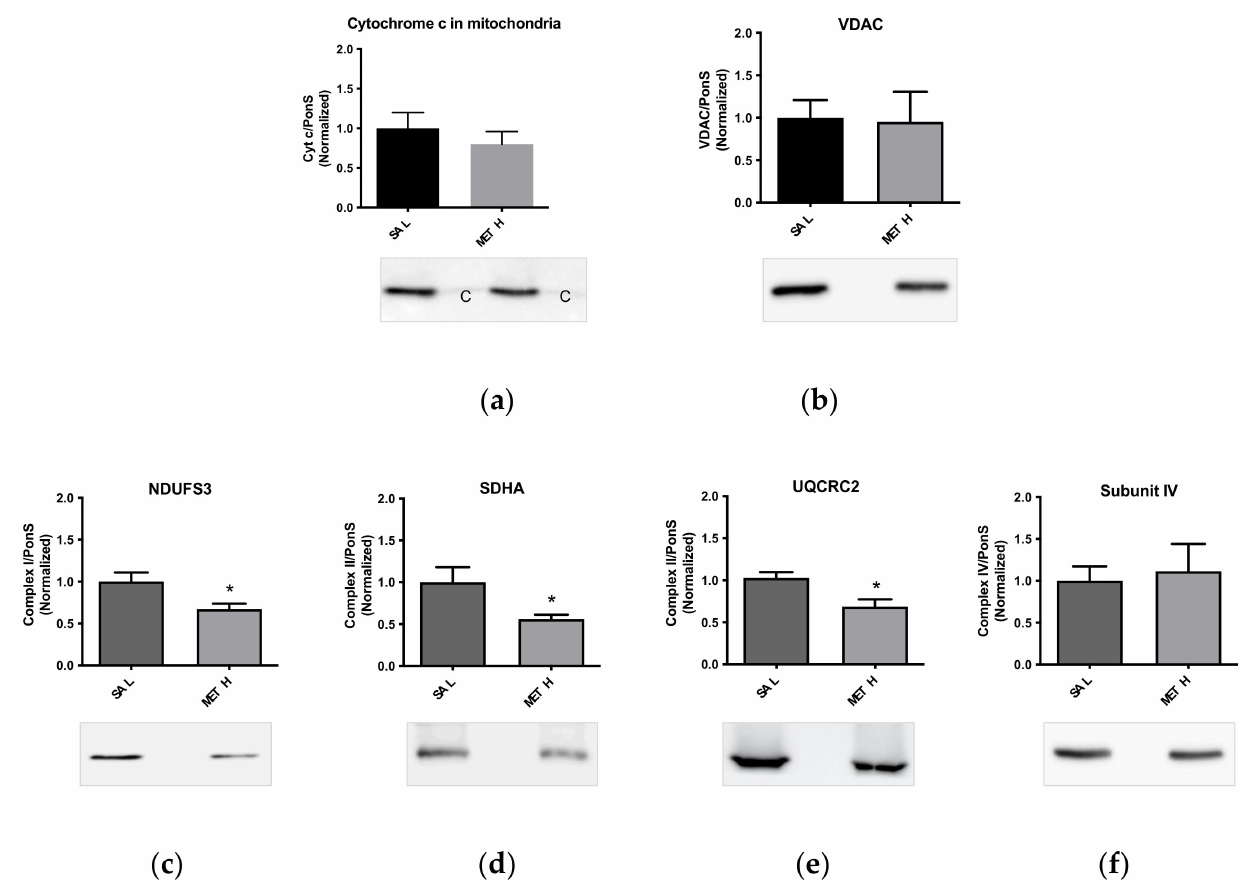
Figure 3. Effects of 10 µ M METH on the levels of ( a ) cytochrome c, ( b ) VDAC, ( c ) NDUFS3 (com- plex I), ( d ) SDHA (complex II), ( e ) UQCRC2 (complex III), and ( f ) subunit IV (complex IV) in cytoplasm-suspended mitochondria. * p < 0.05, Student’s t -test. Abbreviations: c, cytoplasm; METH, methamphetamine; SAL, saline; VDAC, voltage-dependent anion